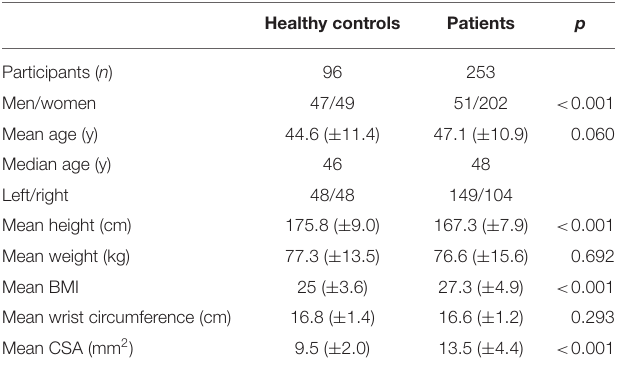
TABLE 1 | Healthy controls and patient characteristics (standard deviation between brackets). Healthy controls